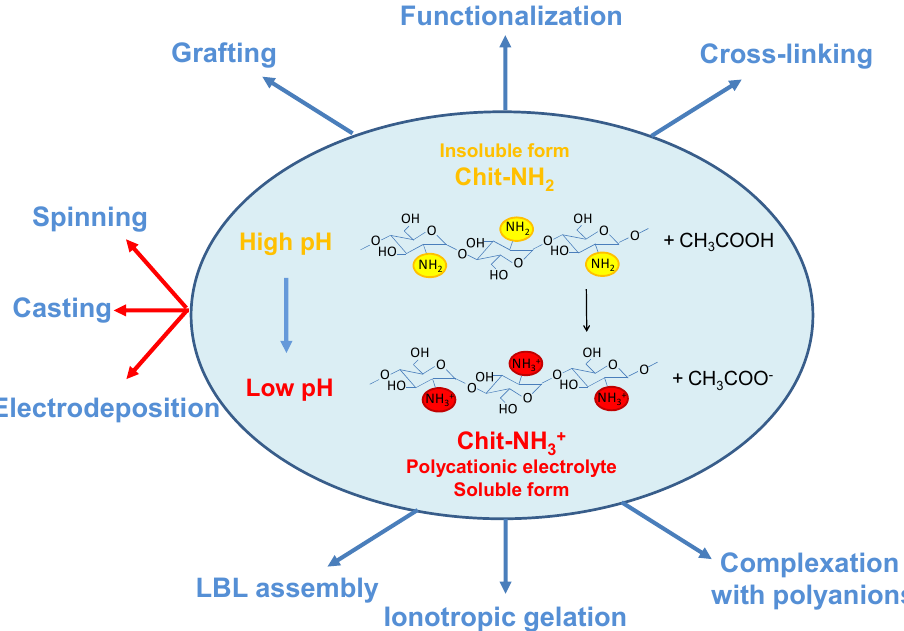
Figure 2. Scheme illustrating the chemical equilibrium of chitosan in slightly acidic solution and related methods to obtain chitosan flat structures from its soluble or insoluble form.